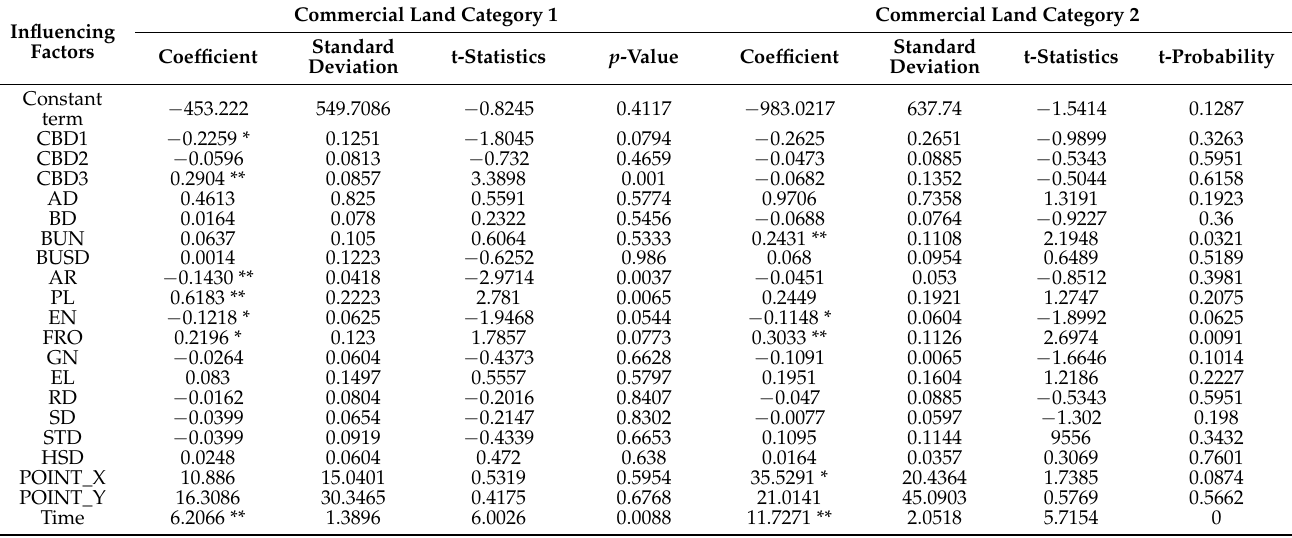
Table 10. Statistically significant factor results of the commercial land category 1 and commercial land category 2 land price OLS